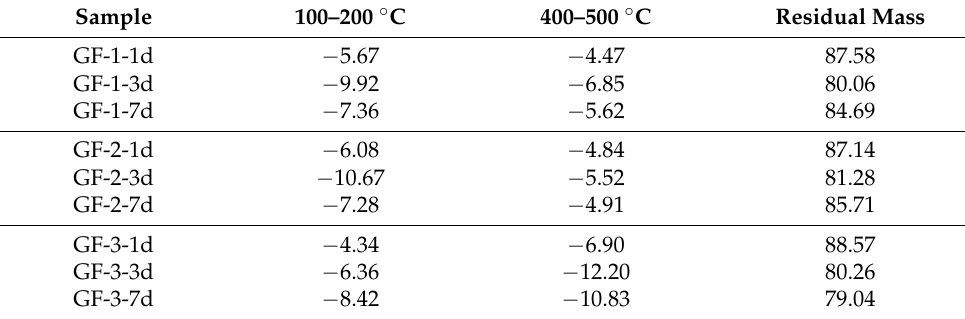
Table 7. The weight loss of the sample derived from the TG-DSC results